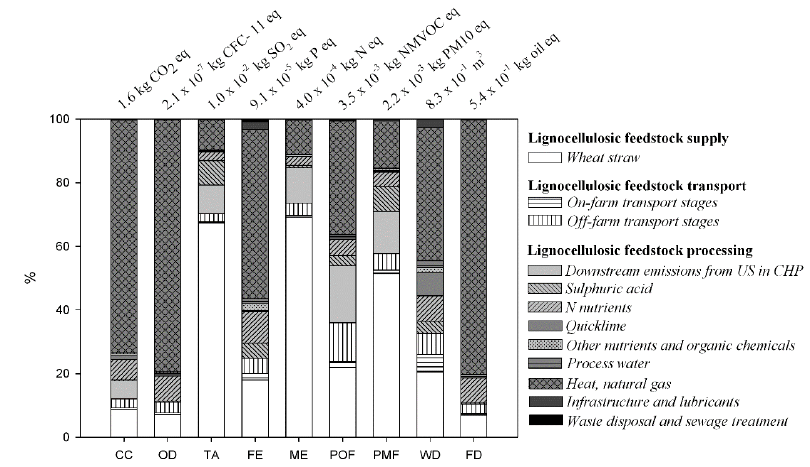
Figure 2. Characterization graph related to the production of 1 kg of butane-1,4-diol bio. Absolute values of impacts are reported on the top of each impact category. US: unconverted solids; CHP: combined heat and power system.